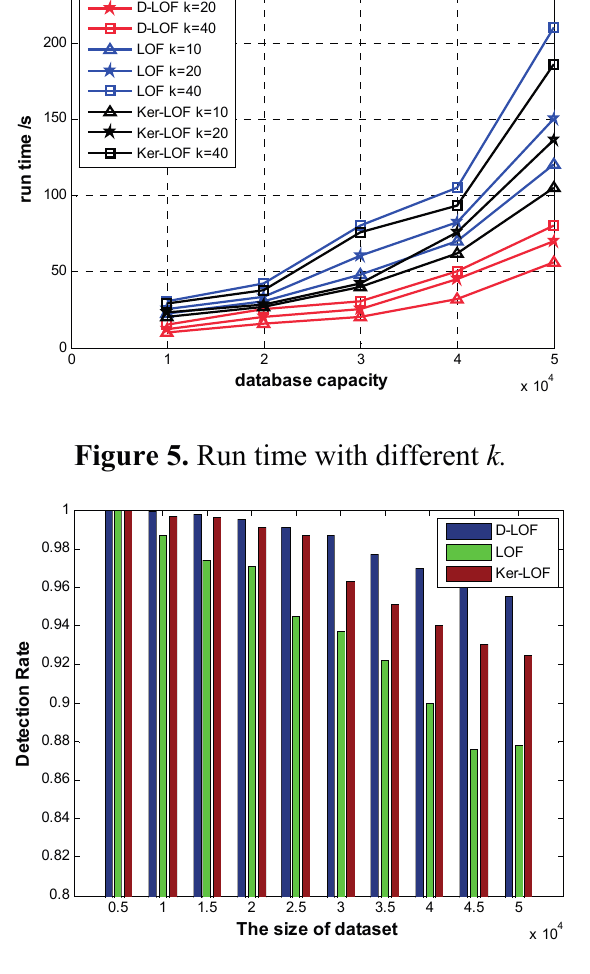
Figure 6. Detection rate with different optimized